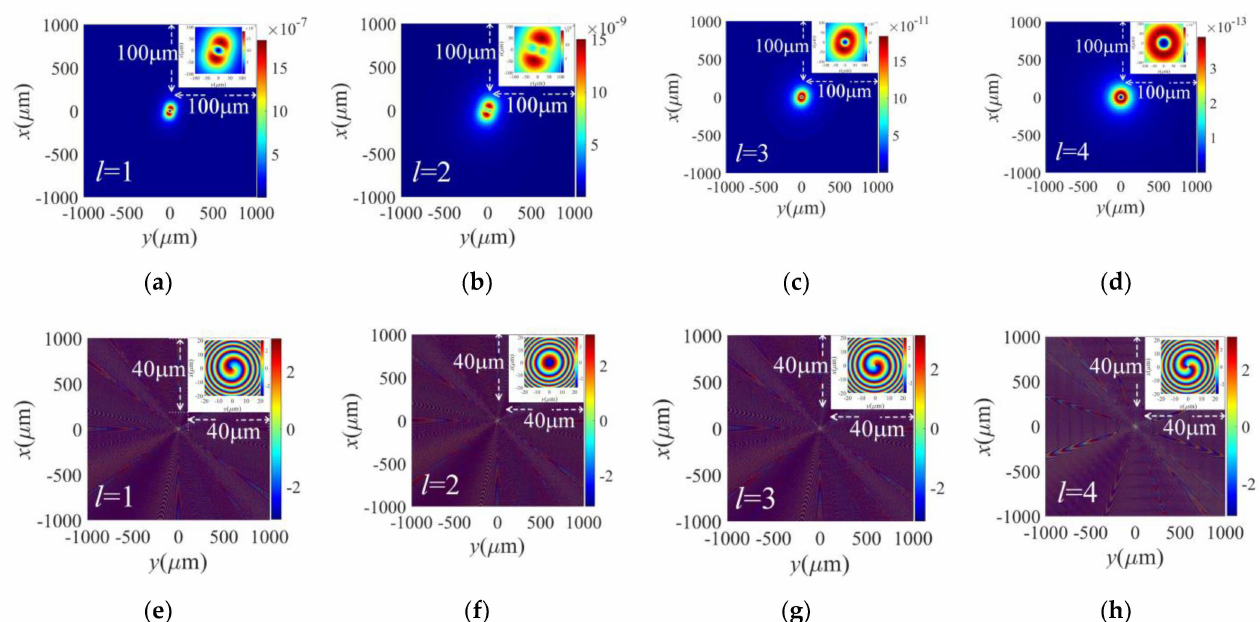
Figure 5. The intensity and phase distributions of the scattering field of the y-polarized Bessel–Gaussian beams with different topological charges. The beam is scattered by a uniform and isotropic particle and the measurement plane is located at z = 50 µ m: panels ( a – d ) show the intensity; and ( e – h ) the present phase. The corresponding topological charge from left to right is 1 to